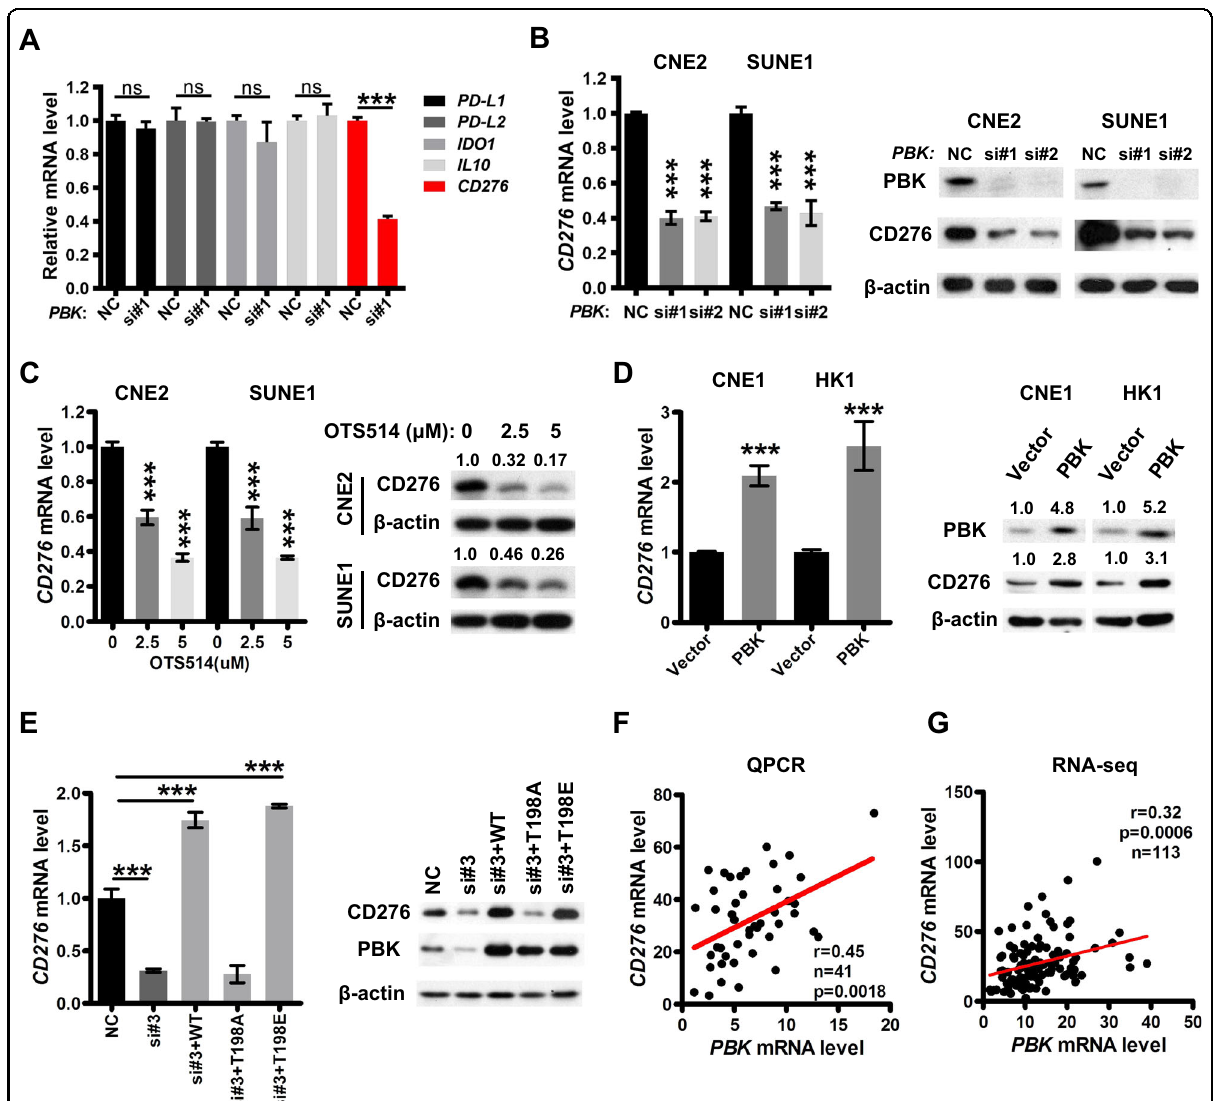
Fig. 2 PBK regulates the transcription of CD276 dependent on its kinase activity. A CNE2 cells were transfected with one PBK siRNA or NC (nonspeci fi c siRNA) for 48 h and qPCR (quantitative polymerase chain reaction) was performed to measure the mRNA expression of indicated genes. B CNE2 and SUNE1 cells were transfected with two PBK siRNAs or NC (nonspeci fi c siRNA) for 48 h. qPCR and immunoblotting were conducted to measure the mRNA and protein expression of CD276 . Left, qPCR. Right, immunoblotting with indicated antibodies. C CNE2 and SUNE1 cells were treated with DMSO (dimethylsulfoxide) or OTS514 (2.5 and 5 μ M) for 24 h. qPCR and immunoblotting were conducted to measure the mRNA and protein expression of CD276 . Left, qPCR. Right, immunoblotting with indicated antibodies. D CNE1 and HK1 cells were infected by lentiviruses carrying PBK coding region to establish the PBK-overexpression stable cell lines. qPCR and immunoblotting were conducted to measure the mRNA and protein expression of CD276 . Left, qPCR. Right, immunoblotting with indicated antibodies. E CNE2 and SUNE1 cells were transfected with one siRNA targeting PBK 3 ′ UTR (untranslated region) region or NC (nonspeci fi c siRNA). After 24 h, the cells were transfected with PBK constructs, including WT (wild type), kinase-dead (T198A), or kinase consistently activated (T198E) for another 24 h. qPCR and immunoblotting were conducted to measure the mRNA and protein expression of CD276 . Left, qPCR. Right, immunoblotting with indicated antibodies. A – E In qPCR assays, ACTB was used as the loading control, and the mRNA level of indicated genes is normalized to ACTB . The results are shown as the fold change over NC (nonspeci fi c siRNA). Data present as the mean ± SEM (standard error of the mean) ( n = 3). *** P < 0.001 (student ’ s t test for two groups, one-way ANOVA for three groups). All the experiments were performed independently three times with similar results, and the data are representative of three independent experiments. F – G Correlation analyses between the PBK and CD276 mRNA level were performed using our qPCR data ( F ) or public RNA-seq data ( G ). A Pearson correlation test was used